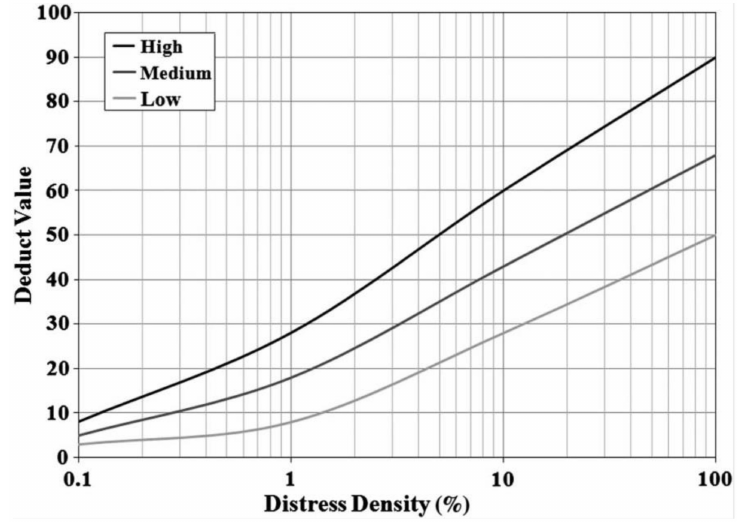
Figure 2. Curves for determining the deduct value.